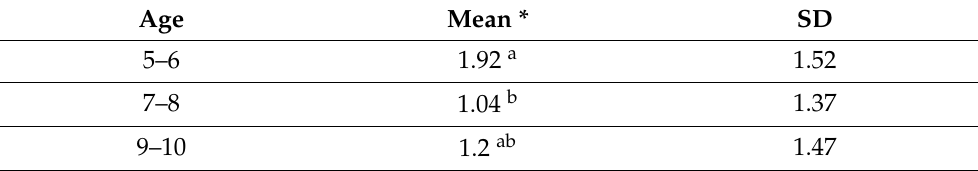
Table 3. Leeway space (mean ± standard deviation in mm) for various age groups p value < 0.05 †.